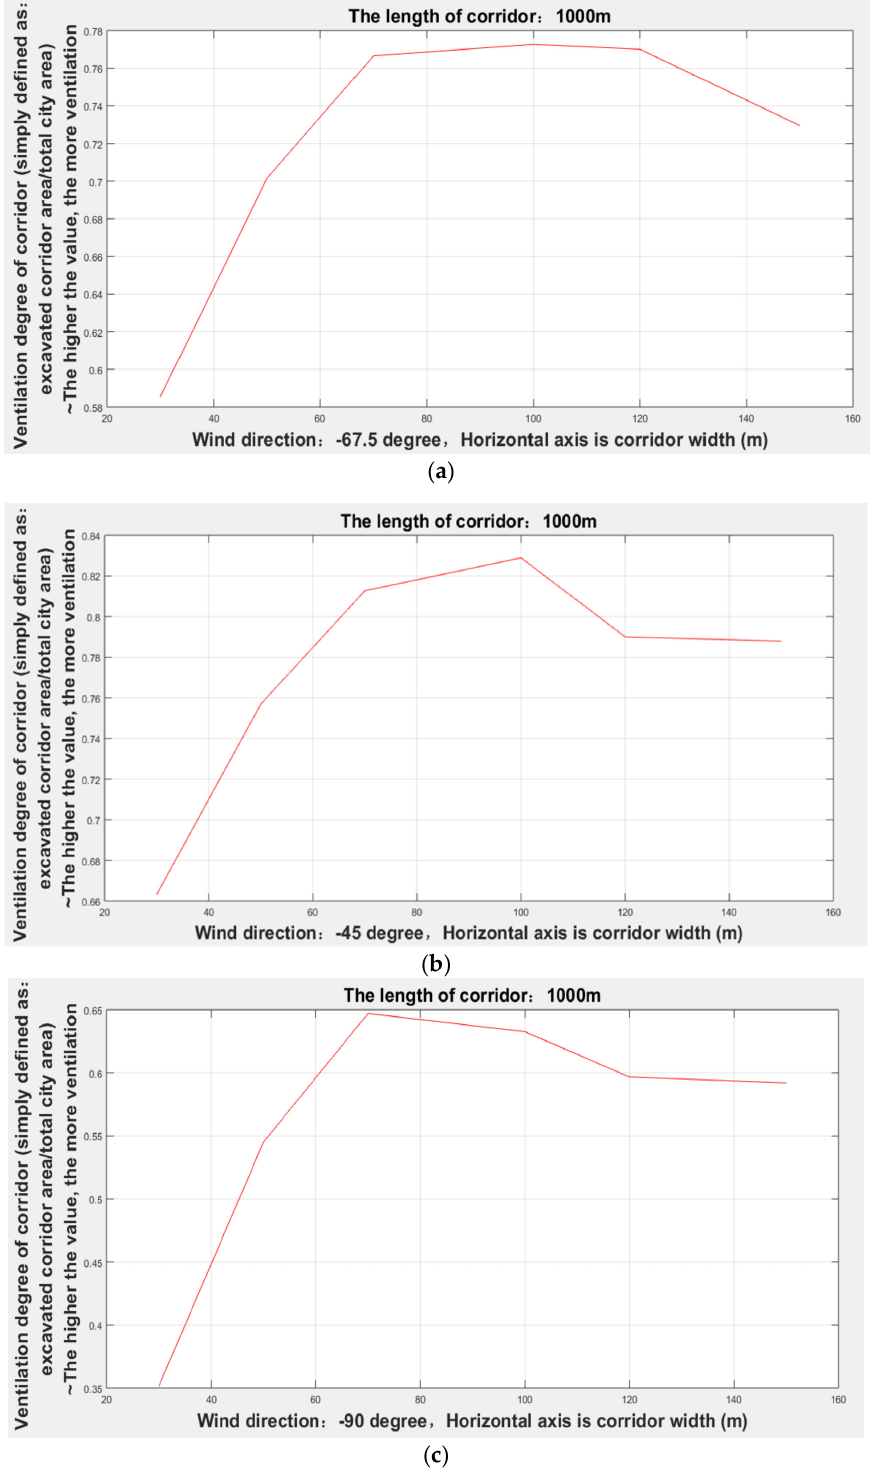
Figure 17. The ventilation degree of the corridor widths: ( a ) − 67.5 degrees; ( b ) − 45 degrees; ( c ) − 90 degrees.